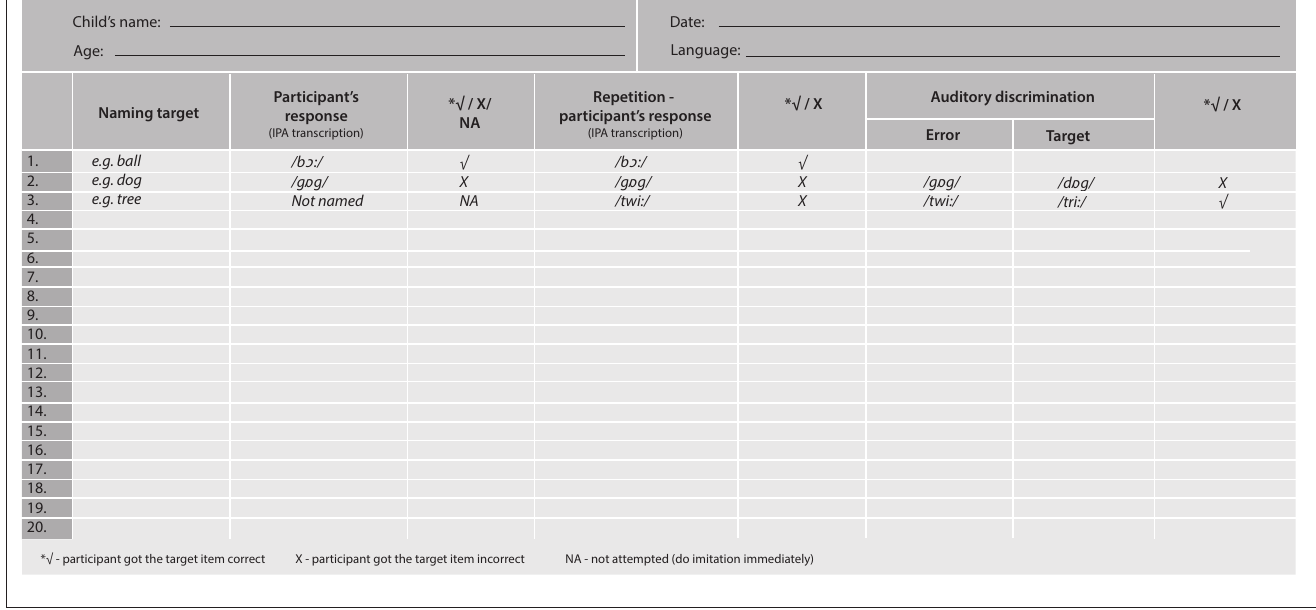
Percentage correct Phonological process Percentage